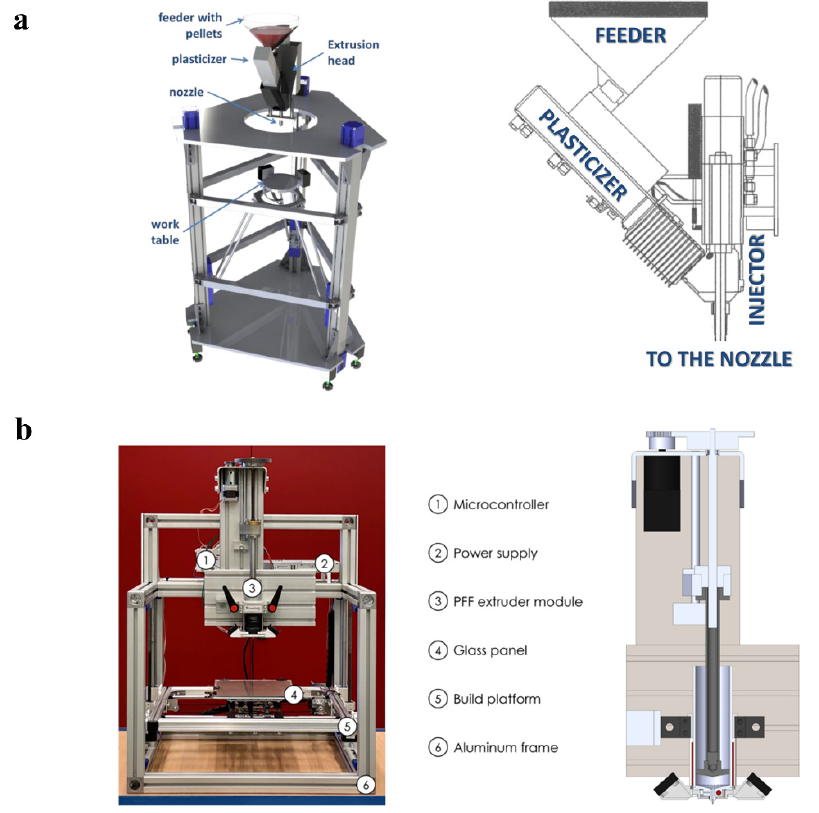
Figure 5. ( a ) In-house developed machine and their components with the extrusion unit combining a screw-based (plasticiser) to feed the feedstock and plunger system to inject the feedstock through the nozzle (adapted from [36]) and ( b ) in-house developed plunger-based printer and their components with the schematic of the extruder unit (Reprinted with permission from [61]. Copyright 2020, Additive Manufacturing, Elsevier)